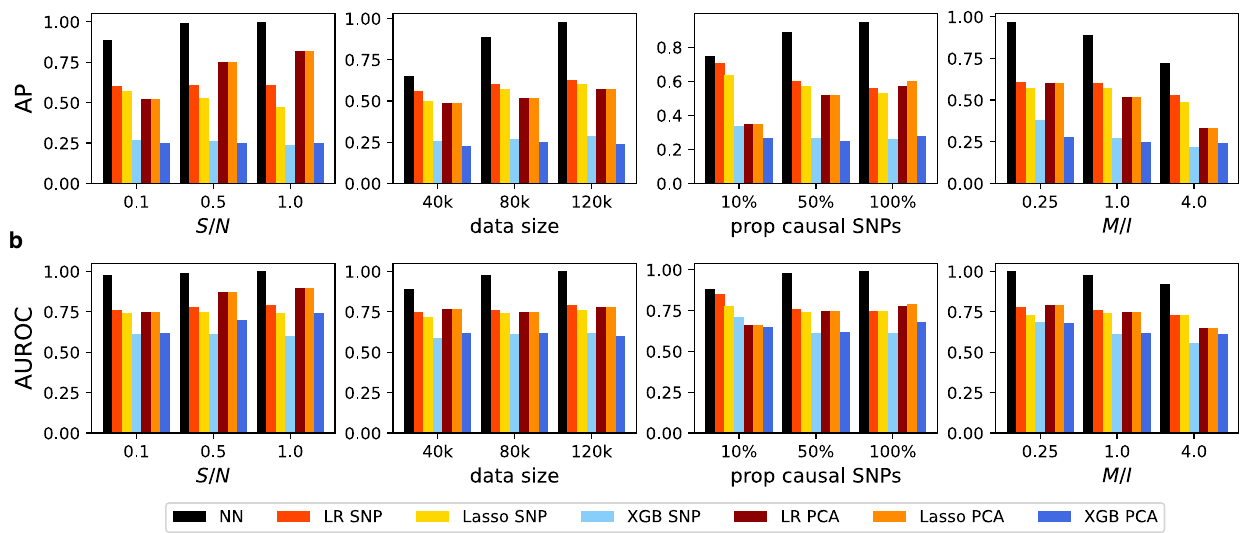
Fig. 3 Gene – gene interaction detection on simulation datasets with complex interactions. We show the average precision (AP) and AUROC of each gene – gene interaction detection methods on simulation datasets with different con fi gurations on panel ( a ) and panel ( b ) respectively. We simulate data using S/N = 0.1, datasize = 80 k , prop causal SNPs = 50%, and M/I = 1.0. We vary one hyper-parameter at a time while fi xing others to the speci fi ed values. The NN approaches (black bar) are consistently better than existing fi rst simulating the main effect w main of each gene i as a linear i Setting . We use the same simulation setting as the simulation with combination of all SNPs in the gene, and then generate multi- complex interactions except that all interactions are multi- plicative interactions between the top SNPs (the SNP with the plications between the top SNPs. We simulate the phenotype y by largest main effect) of the genes (Eq. (2)). The simulator is